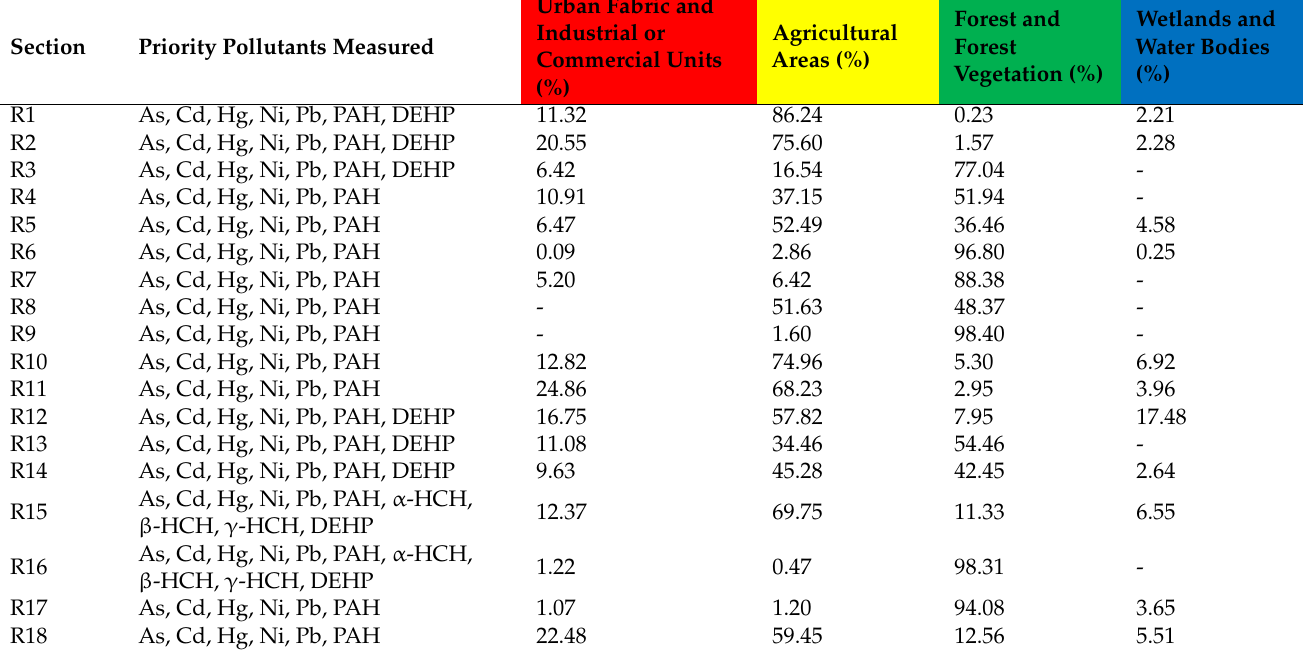
Table 2. Land use (%) around the sampling station (5 km